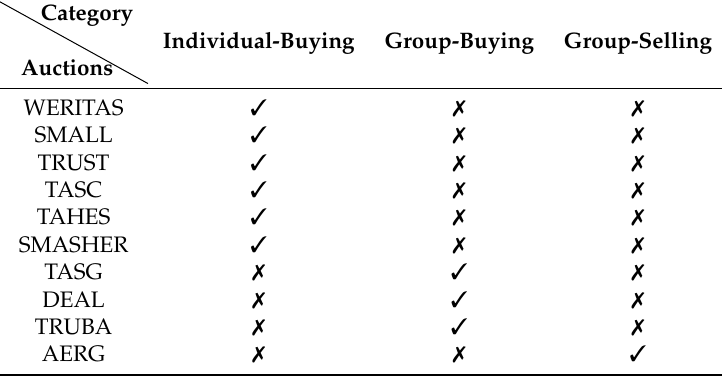
Table 1. Classification of proposed AERG framework and other related schemes. AuctionsCategory Individual-Buying